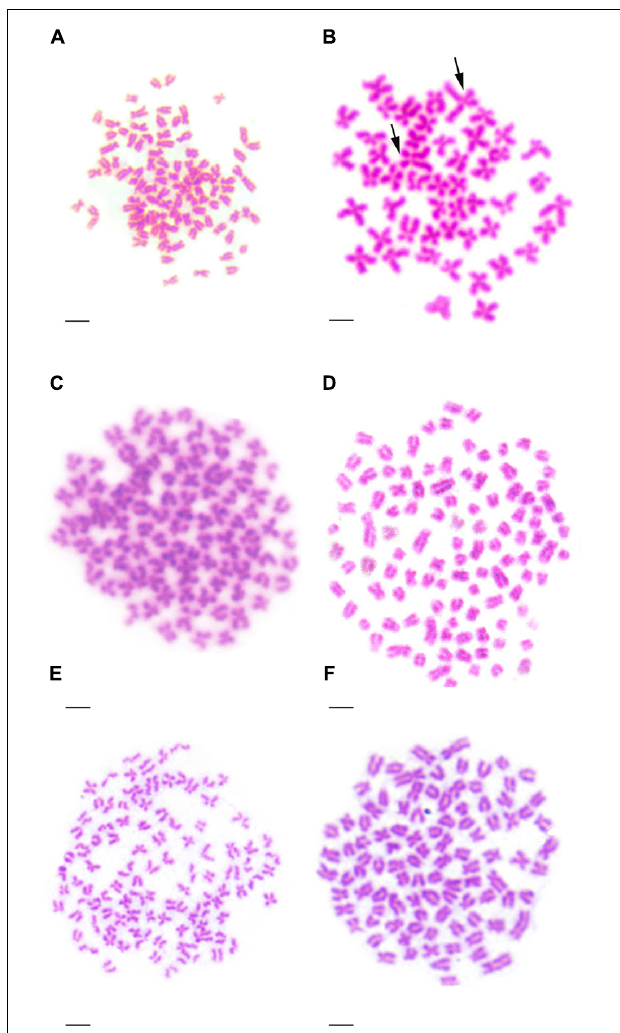
FIGURE 2 | Chromosome spreads at metaphase in KOC, BSB, RCC-L, GF-L, GF, and RCC. (A) The 100 chromosomes of KOC. (B) The 48 chromosomes of BSB in which a pair of the largest submetacentric chromosomes (black arrows) is indicated. (C) The 100 chromosomes of RCC-L in which the largest submetacentric chromosome was not found. (D) The 100 chromosomes of GF-L in which the largest submetacentric chromosomes were not found. (E) The 100 chromosomes of GF in which the largest submetacentric chromosomes were not found. (F) The 100 chromosomes of RCC in which the largest submetacentric chromosomes was not found. Bar = 3 µ